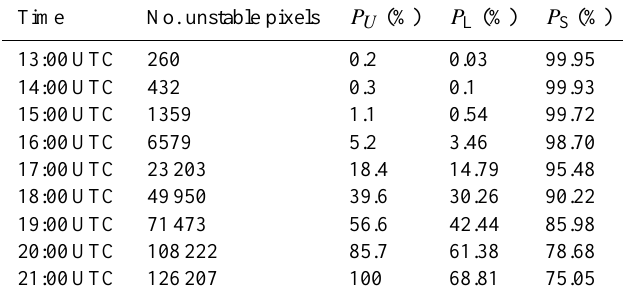
Table 4. Results of the TRIGRS simulation at different times: number and relative percentage of pixels predicted as unstable ( P U ); percentage of correctly predicted landslide ( P L ) and stable ( P S )